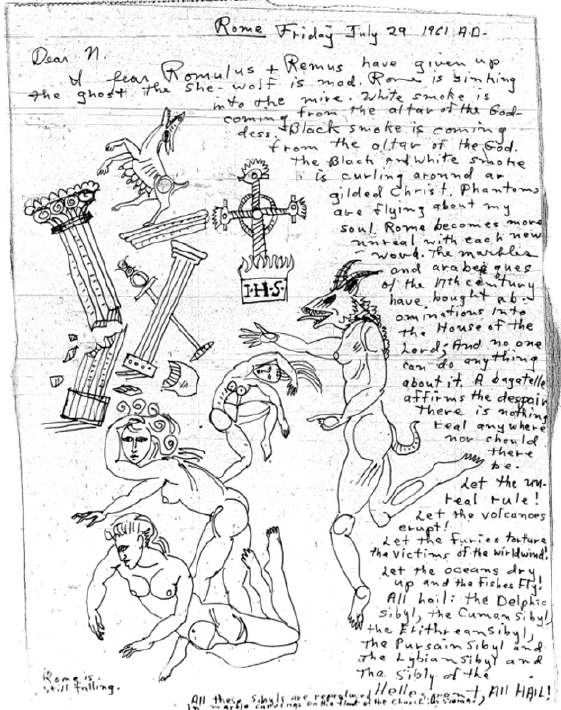
Figure 7. Robert Smithson, letter to Nancy Holt from Rome (1961) – RSP, Reel